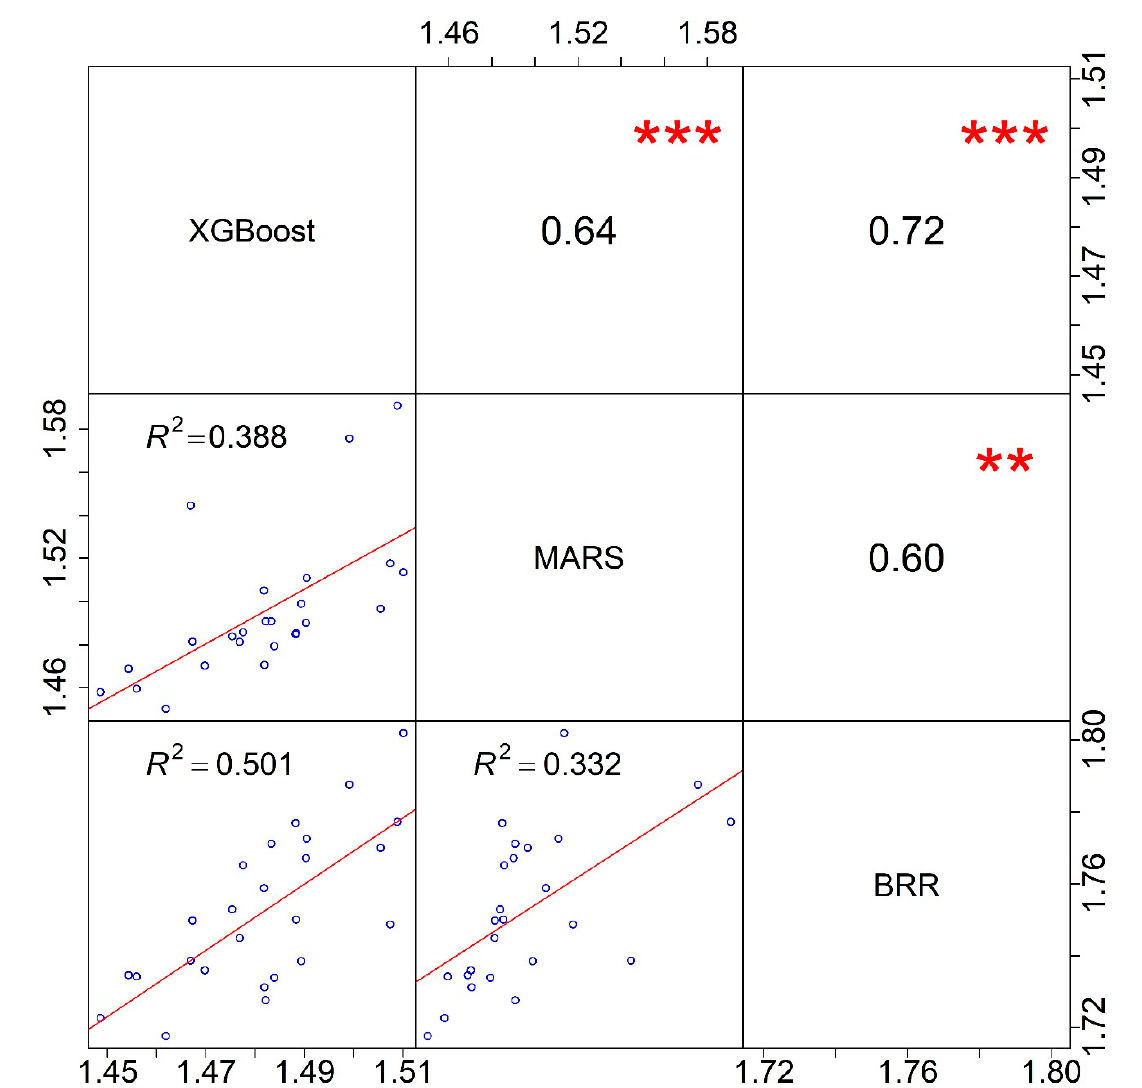
Figure 4. The scatterplot matrix illustrates the correlations among the XGBoost, MARS, and BRR models. Model names are shown along the diagonal. The bivariate scatterplots (hollow blue circles) with a fitted red line are shown below the diagonal. The correlation values are shown above the diagonal. Two asterisks and three asterisks represent significance levels with p -values of 0.001 and 0, respectively.